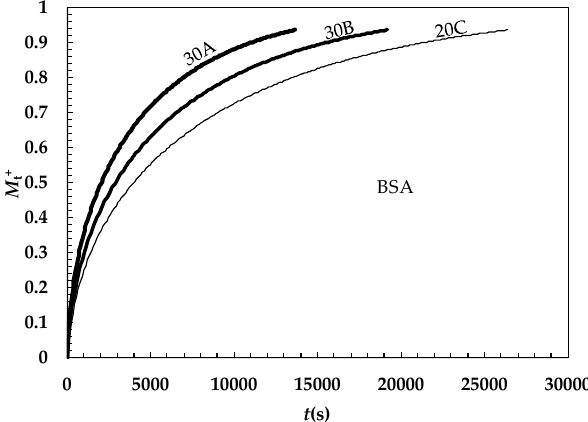
Figure 6. Time evolution of the dimensionless amount of bovine serum albumin (BSA) released from a spherical matrix (radius = 0.5 mm; M t+ = ratio between the amount of drug released at time t and the amount released after an infinite time). For BSA, D 0 (37 °C, water) = 6.35 × 10 − 8 cm 2 /s [32].